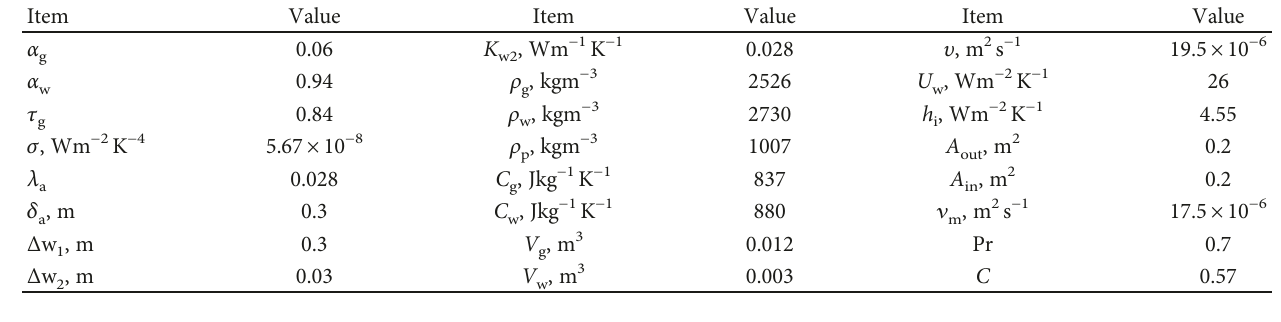
Table 2: Initial conditions for numerical modelling.